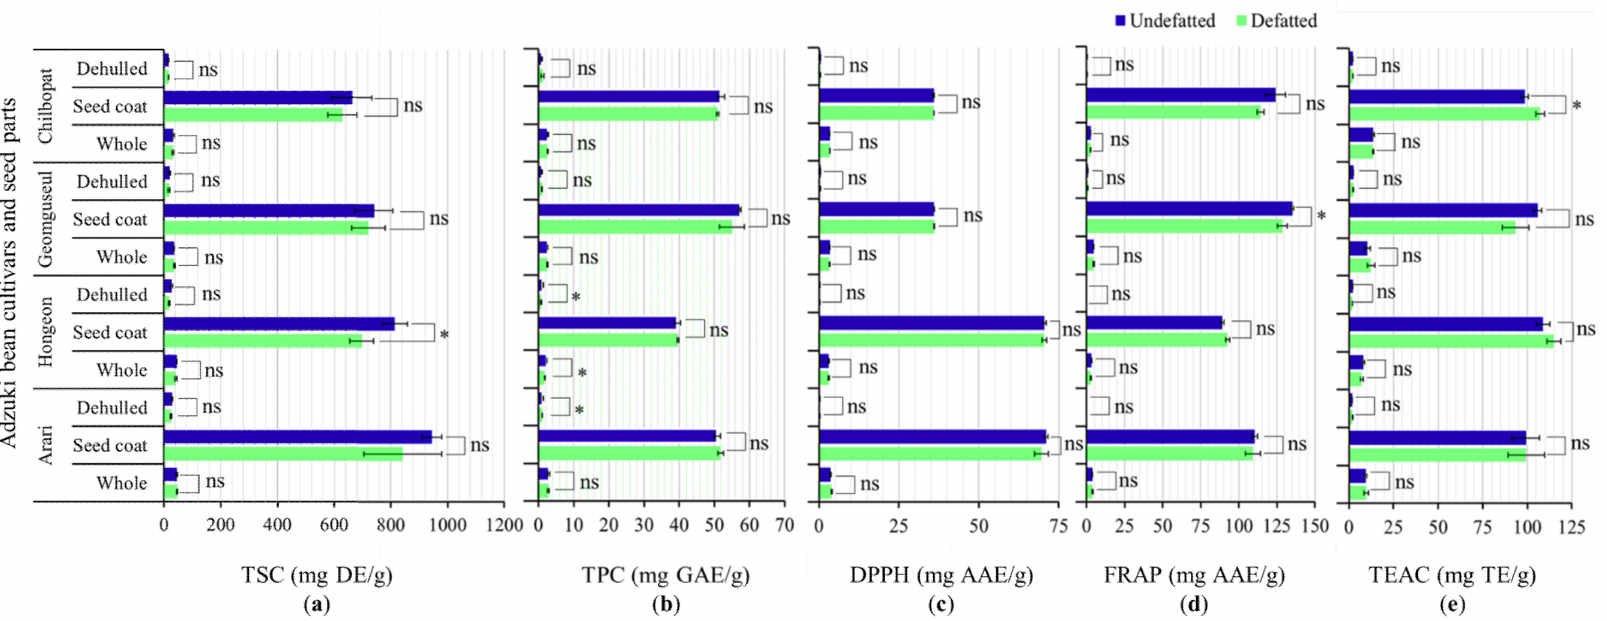
Figure 3. Variation of total saponin content (TSC) ( a ), total phenolic content (TPC) ( b ), DPPH-radical scavenging activity ( c ), Ferric reducing antioxidant power (FRAP) ( d ), and Trolox equivalent antioxidant activity (TEAC) ( e ) between defatted and undefatted extracts of seed coats, whole seeds, and dehulled seeds of four adzuki bean cultivars. * p < 0.05; ns Not